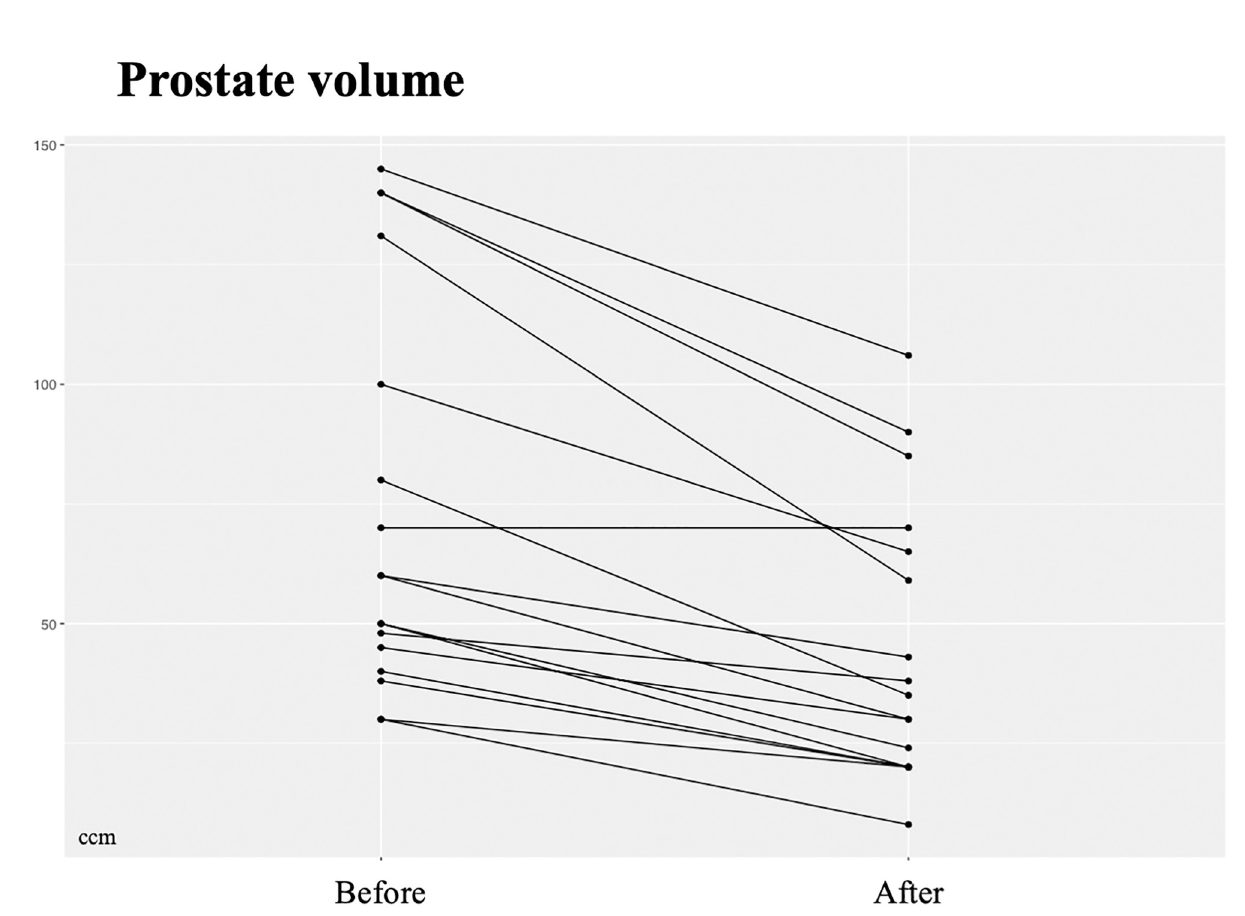
Fig 3. Prostate volume (ccm) before and after treatment (p = 0.024, n = 17).